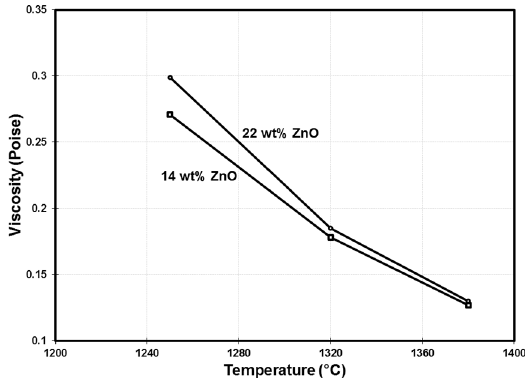
Figure 9. Effect of temperature and ZnO content on the liquid slag viscosity calculated with FACTSage software 8